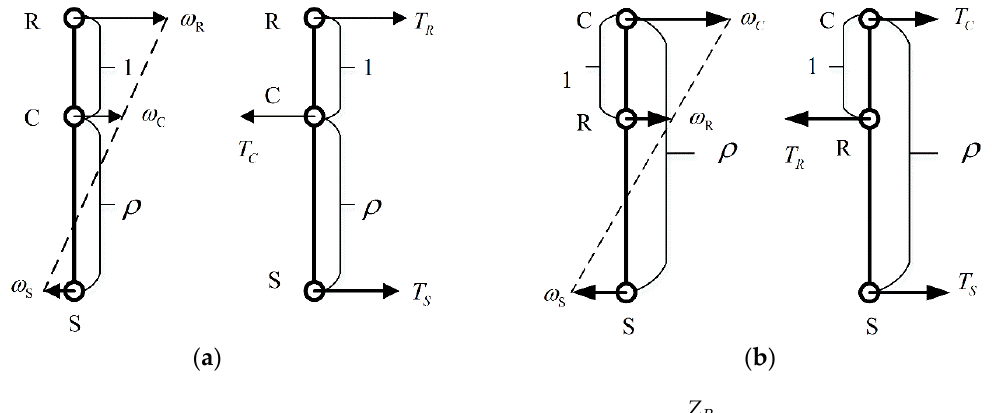
Z Z R Z  , where Z Z  , where Z is the , where Z R is the number of is the R R R R Z Z S Z S S